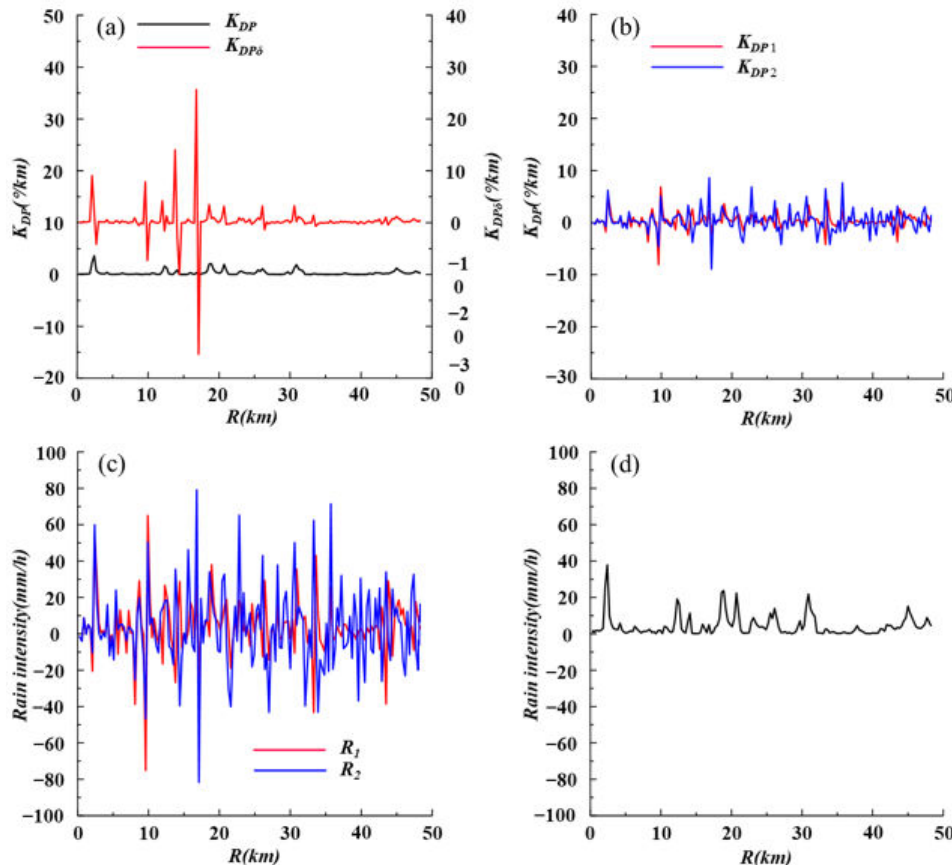
Figure 5. ( a ) K DP (unaffected by δ ) and K DP δ calculated from Φ DPR (affected by δ ); ( b ) K DP 1 after the elimination of δ from Φ DPR using the Z DR without attenuation effect, and K DP 2 using the